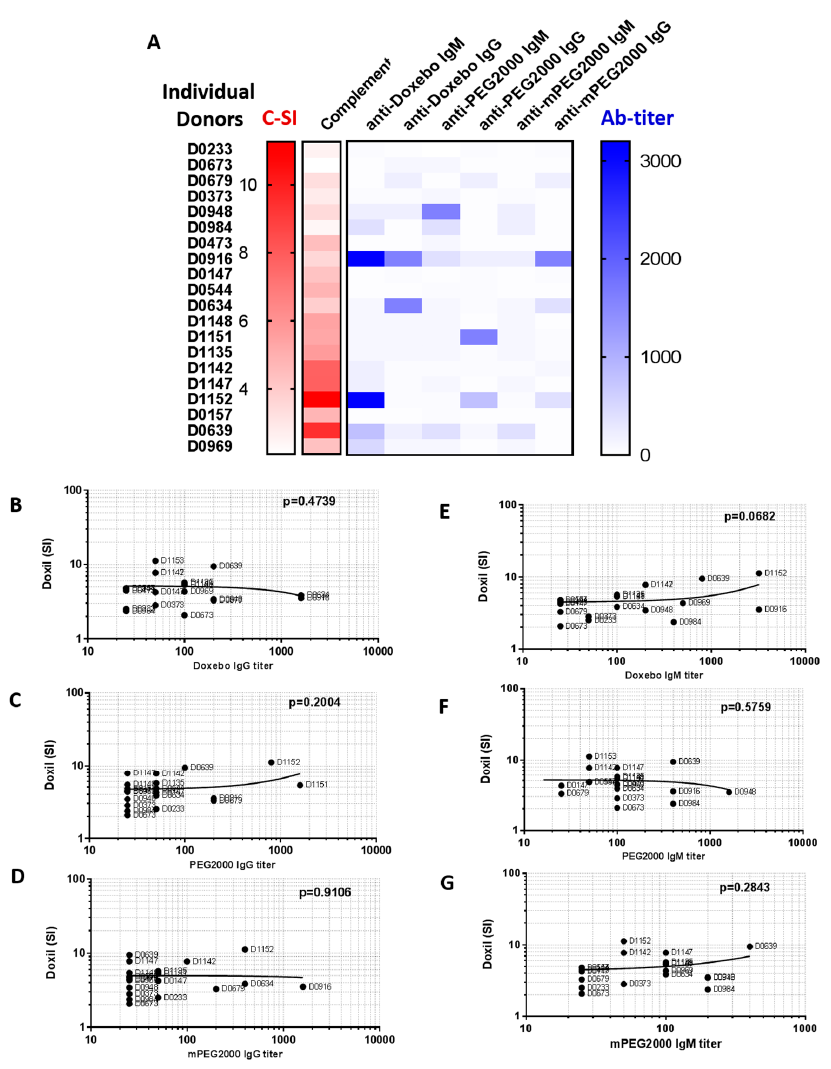
Figure 5. Complement activation by Doxil does not correlate with the titer of antibodies reactive to PEG in individual human donors. ( A ) The complement activation and antibody titer data are presented in a heat map format. The complement stimulation index by Doxil (C-SI) is aligned with the antibody titer (Ab-titer). Darker red and blue show higher levels of the complement activation and antibody titer, respectively. The antibody titer is plotted for IgM and IgG and indicates the antigen used to capture the reactive antibodies (Doxebo, PEG, or mPEG). The molecular weight of PEG is 2000 and is equal in all samples. mPEG contains a methoxy terminal group that is also present in the PEG2000 used to produce Doxil and Doxebo. D—donor; ( B – G ) Regression analysis was performed to understand the correlation between the antibody titer and the complement activation by Doxil. Doxil stimulation index (SI) was compared with the titer of IgG reactive to Doxebo ( B ), PEG2000 ( C ), or mPEG2000 ( D ), as well as the titer of IgM reactive to Doxebo ( E ), PEG2000 ( F ), or mPEG2000 ( G ). p -value was used to assess the significance of the confidence interval of 95%. No analyses revealed a significant correlation. The residual analysis conducted in parallel with this test did not change the conclusions of the analysis (data not shown).